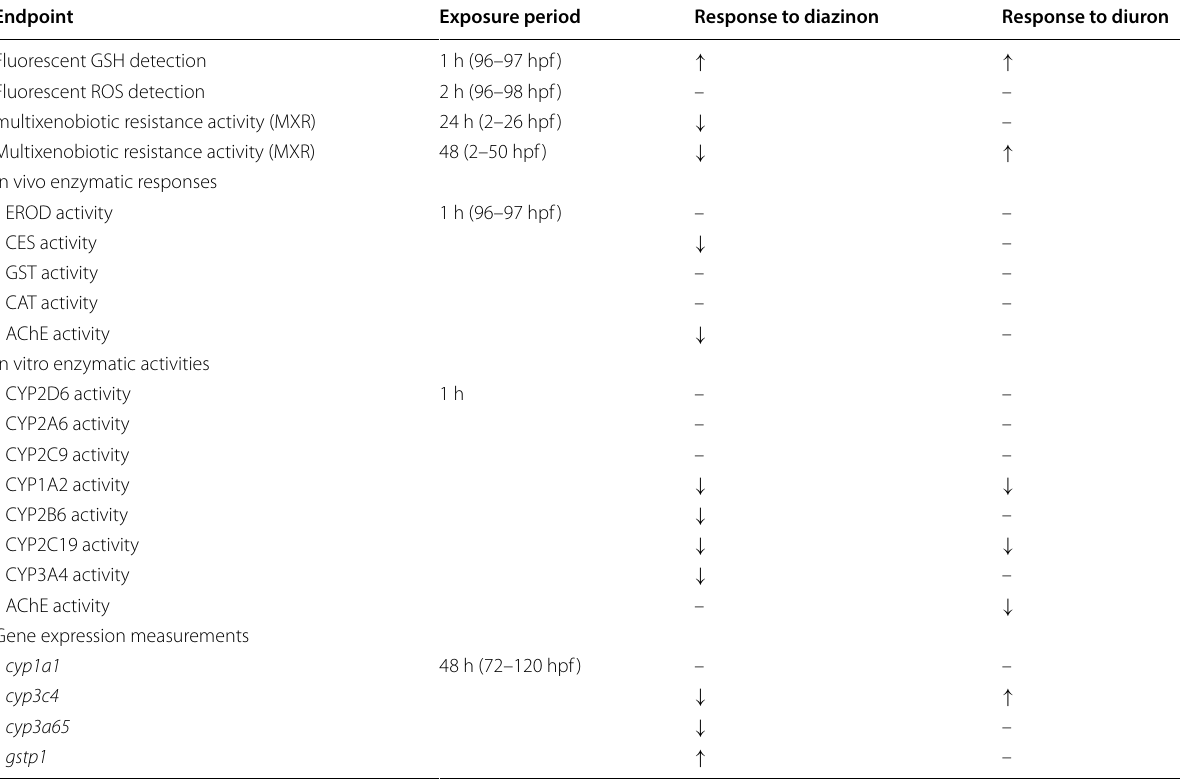
Table 2 Overview of measured endpoints and obtained